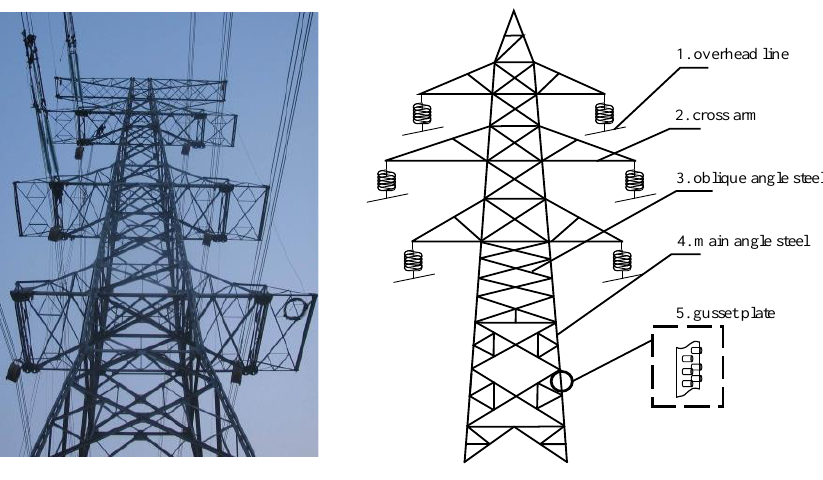
Figure 1. Transmission